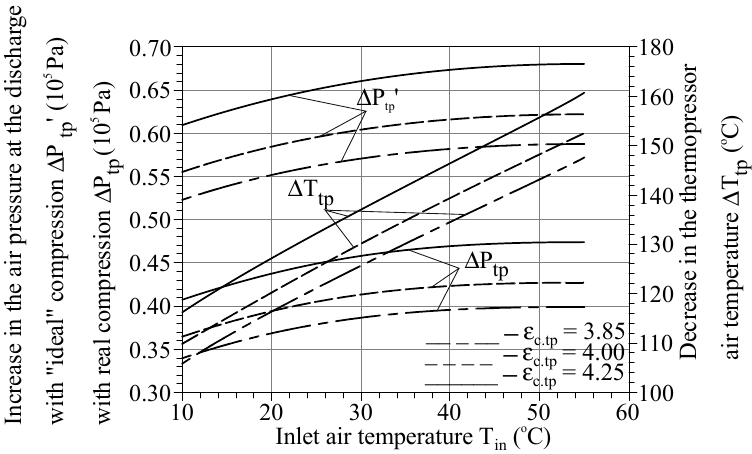
Figure 14. Dependences of the decrease in the thermopressor air temperature, Δ T tp ; an increase in the air pressure at the discharge with “ideal” compression, ΔР tp ', and with real compression, ΔР tp , at different total pressure increase, ε c . tp , on the inlet air temperature, T in .